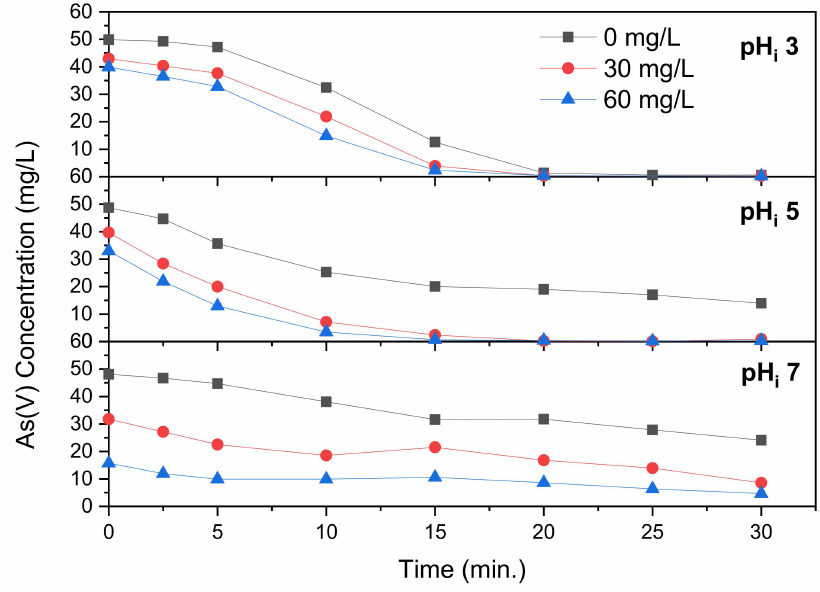
Figure 4. Arsenic removal over time through electrocoagulation assisted by varying concentrations of Fe(II)